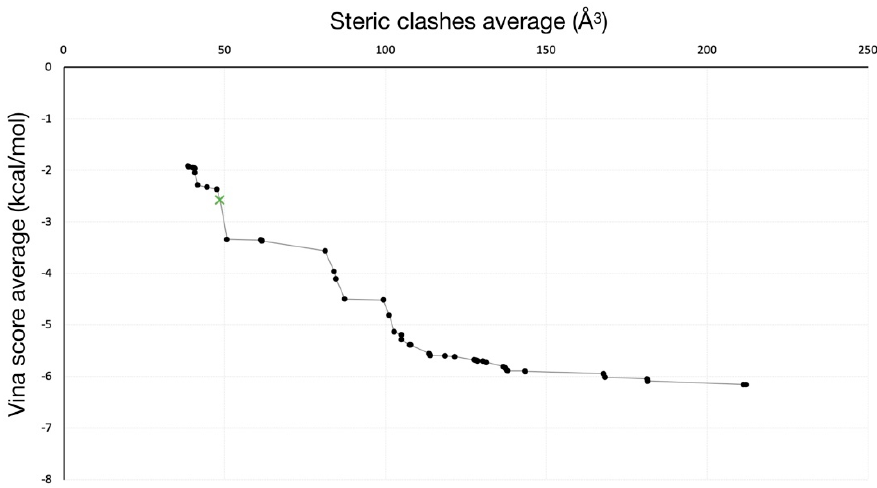
Figure 4. Pareto front of solutions obtained from GPathFinder. Solution selected for further analysis is colored in green with a “x” marker.